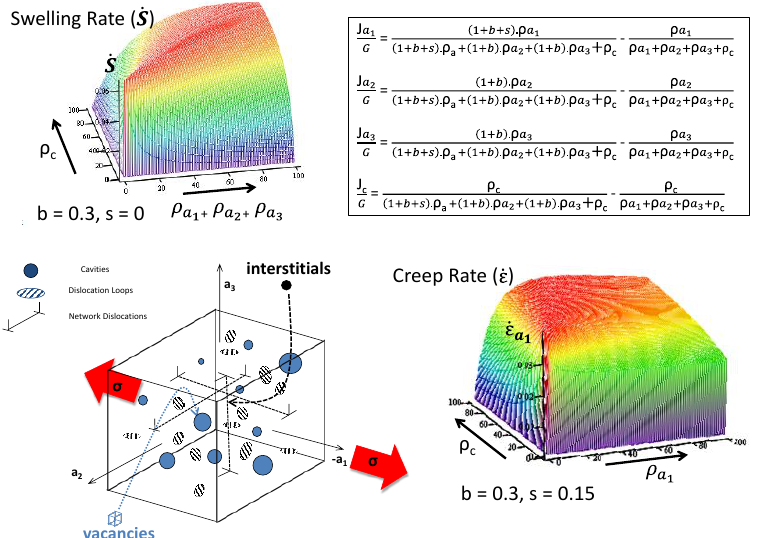
Figure 30. Simple rate theory formulation for calculating steady-state swelling and uniaxial creep rates as a function of the microstructure evolution. In this example, the dislocation density is chosen to be 10 15 m − 2 , which is the expected density from residual cold work and radiation damage (dislocation loops).